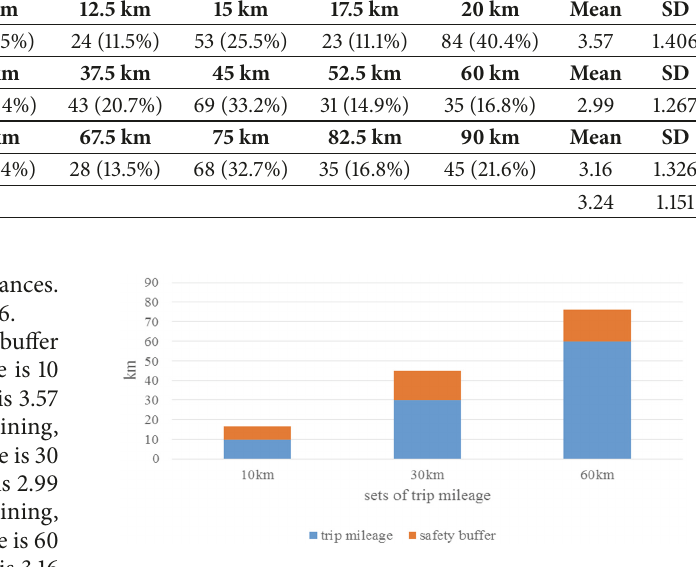
Figure 1: Trip mileage and safety